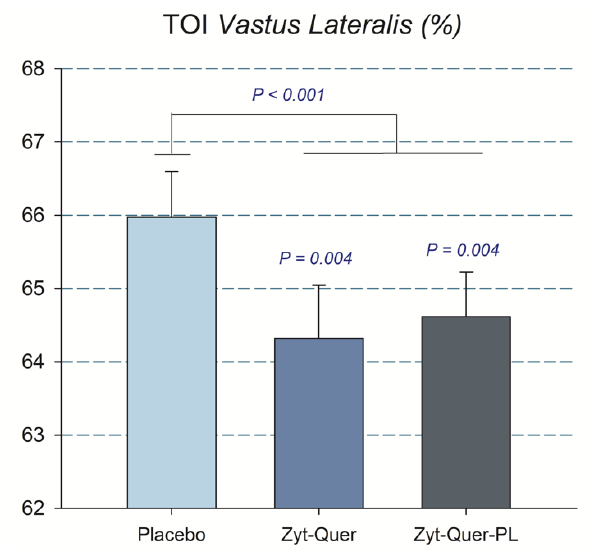
Figure 3. Peak Power output. The bars correspond to the mean of the three sprints, after the ingestion of placebo, Zynamite ® (Zyt) combined with quercetin (Quer) or Zynamite ® combined with quercetin and phospholipids (PL). Error bars represent the standard error of the mean. p values: comparison with placebo. N = 40.